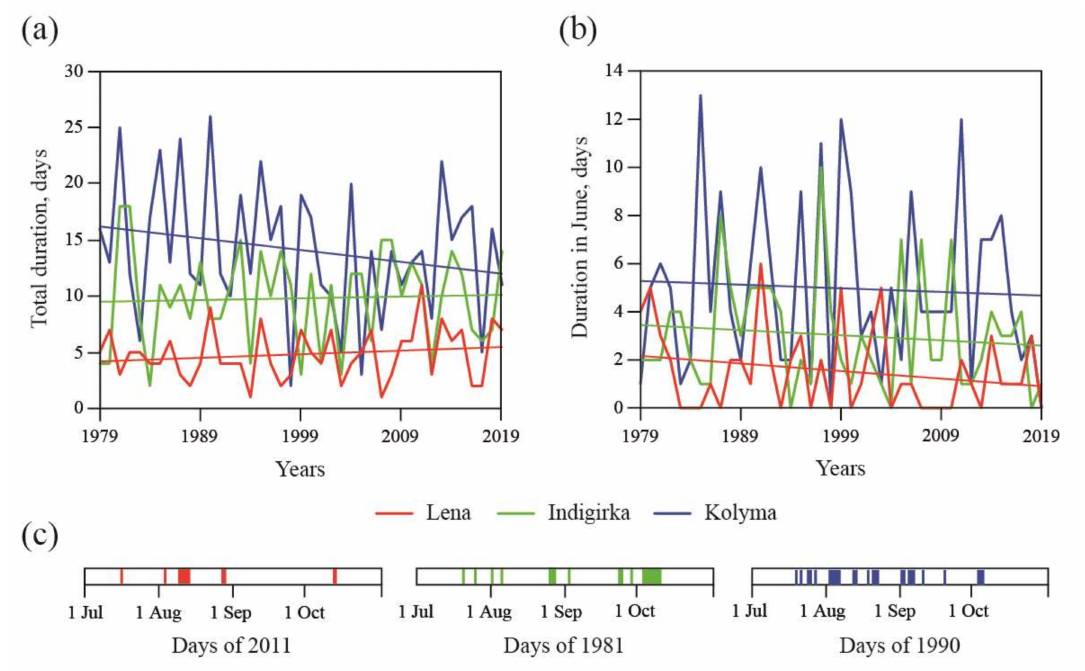
Figure 12. ( a ) The total annual duration and ( b ) duration in July of upwelling events near the Lena (red), Indigirka (green), and Kolyma (blue) deltas in 1979–2019. ( c ) Distributions of upwelling periods in July–October in 2011 near the Lena Delta (left), in 1981 near the Indigirka Delta (center), and in 1990 near the Kolyma Delta